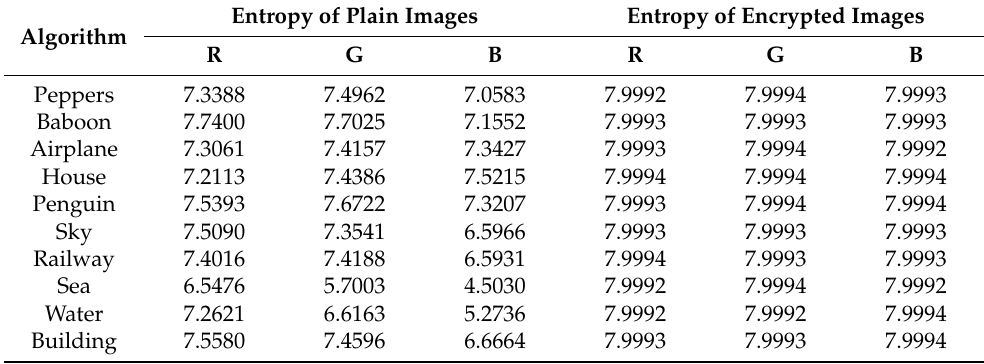
Table 12. Information entropy values.